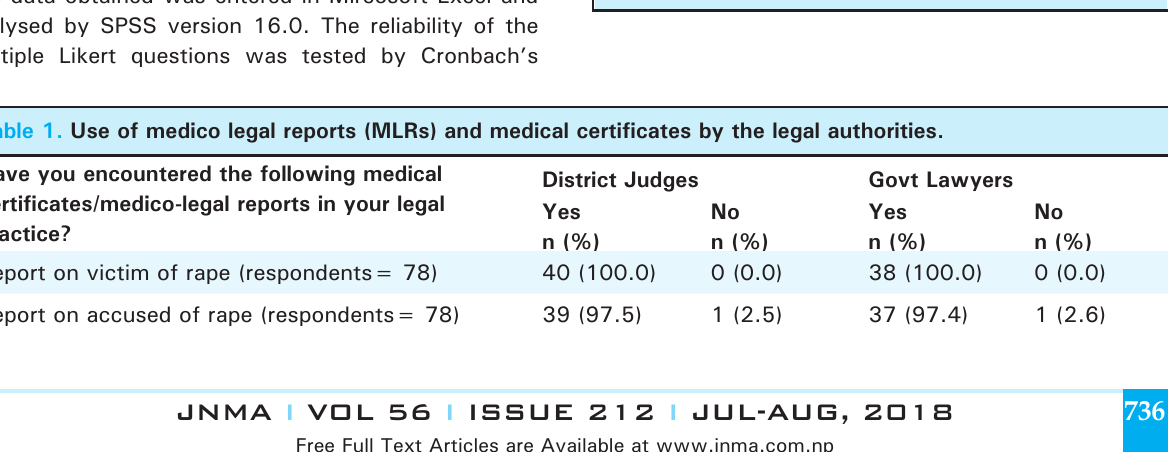
Figure 1. Flow chart of selection of